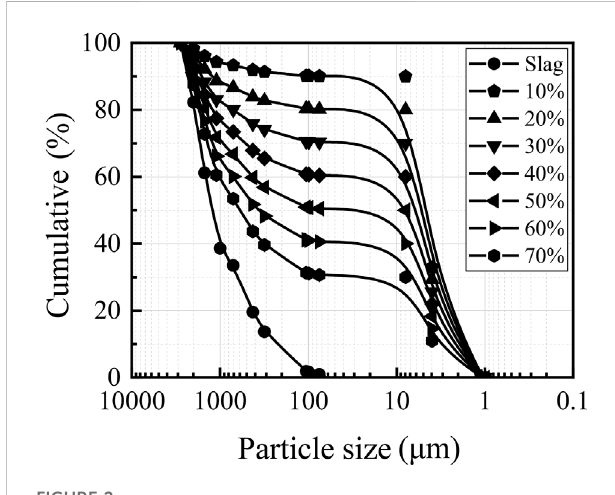
FIGURE 2 Particle size distributions of TSM with various slag content (0% – 70%).